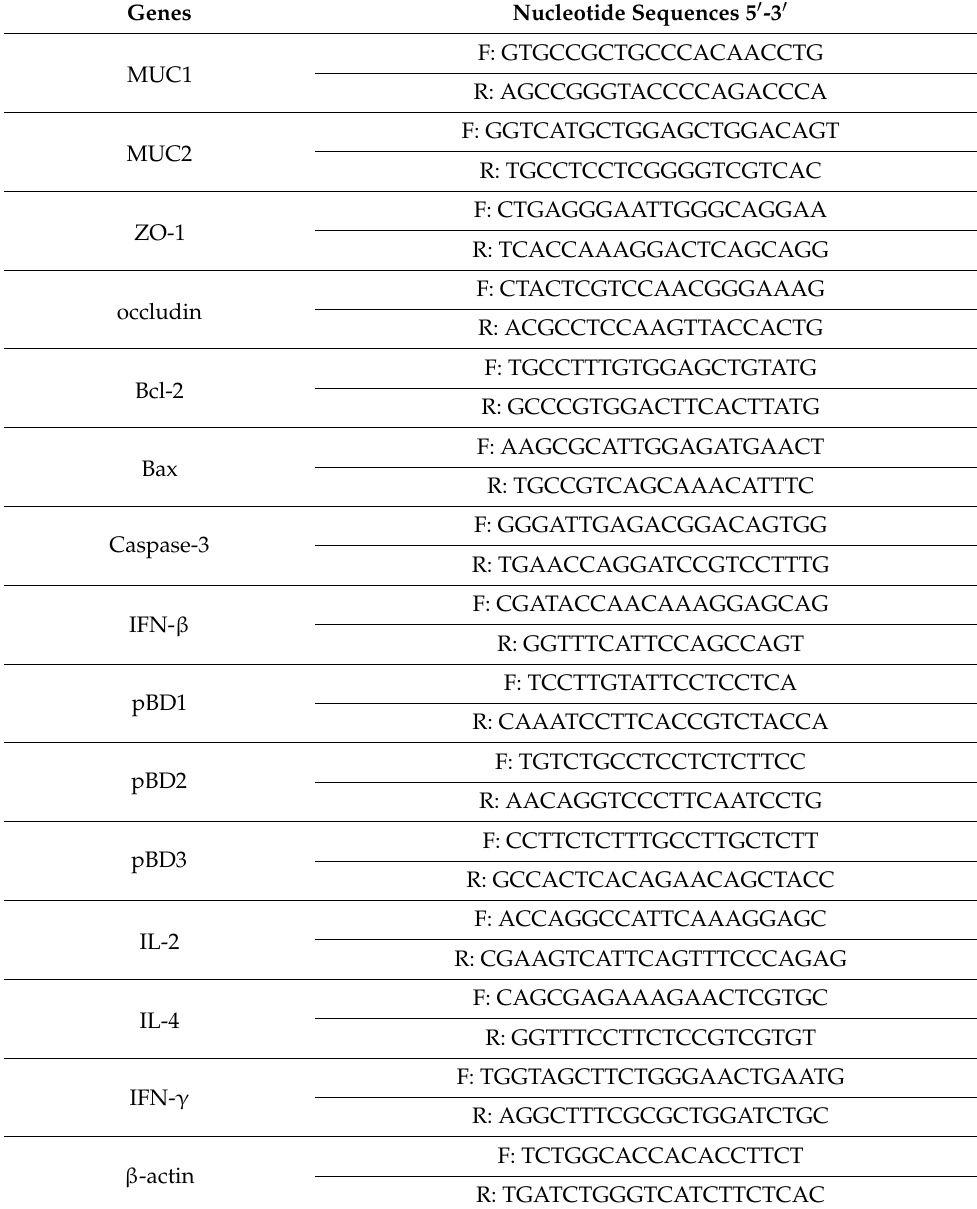
Table 2. Primer sequences used for real-time